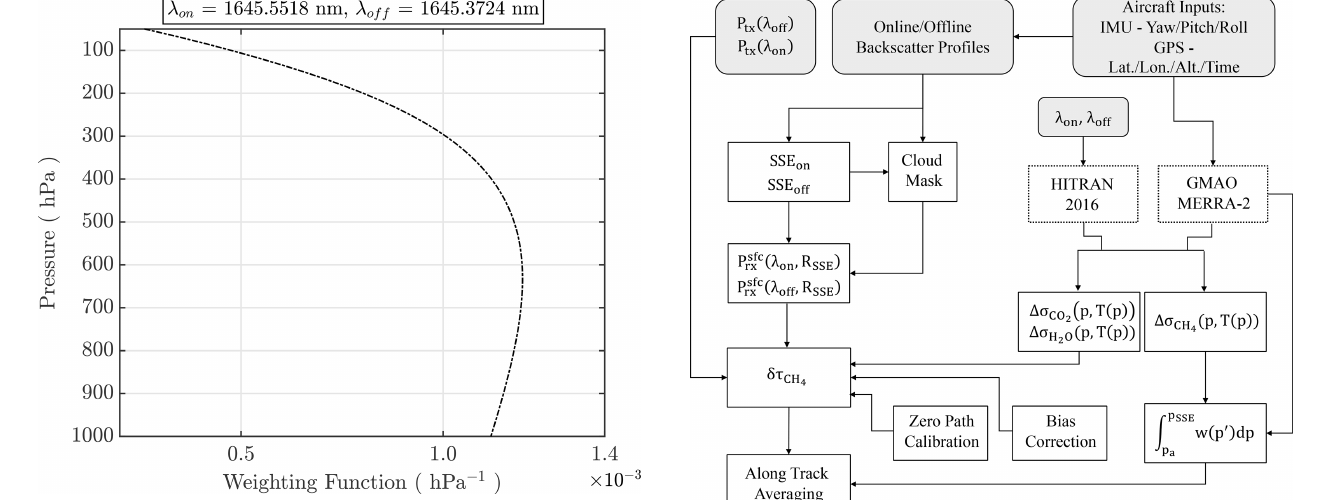
Figure 4. Pressure-weighting function used in the XCH 4 retrieval for the HALO operating wavelengths.